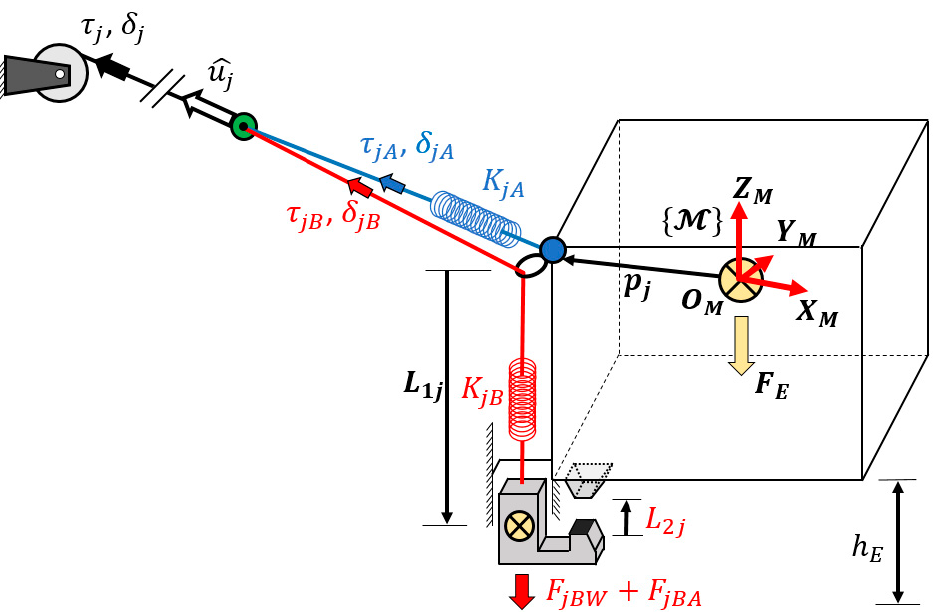
Figure 1. Scheme of the proposed end-e ff ector with a grasping tool based on a reconfigurable end-e ff ector. One cable provides the energy for the tension distribution of the main body and for the displacement of the grasping tool. The cable is coiled around a winch that is able to deploy the desired amount and to impose the desired tension.